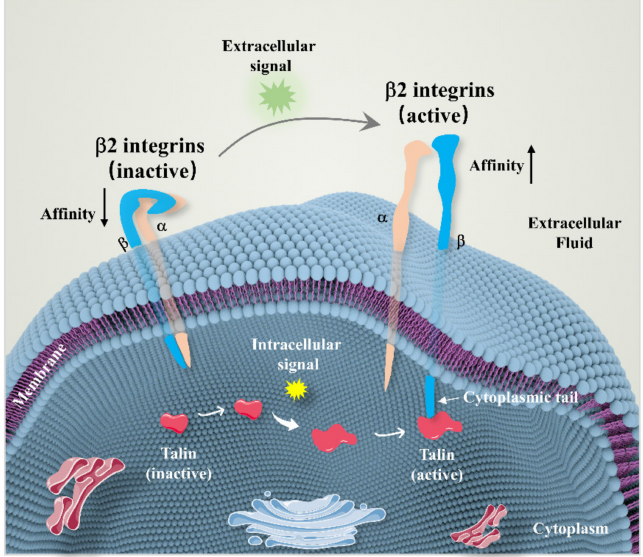
Figure 2. The affinity of β 2 integrins can be regulated by bonding with talin. Talin is a large focal adhesion protein that interacts with the intracellular domains of β 2 integrins (cytoplasmic tail). The interaction between talin and β 2 integrins can enhance the affinity of integrins and ECM proteins via activating the β 2